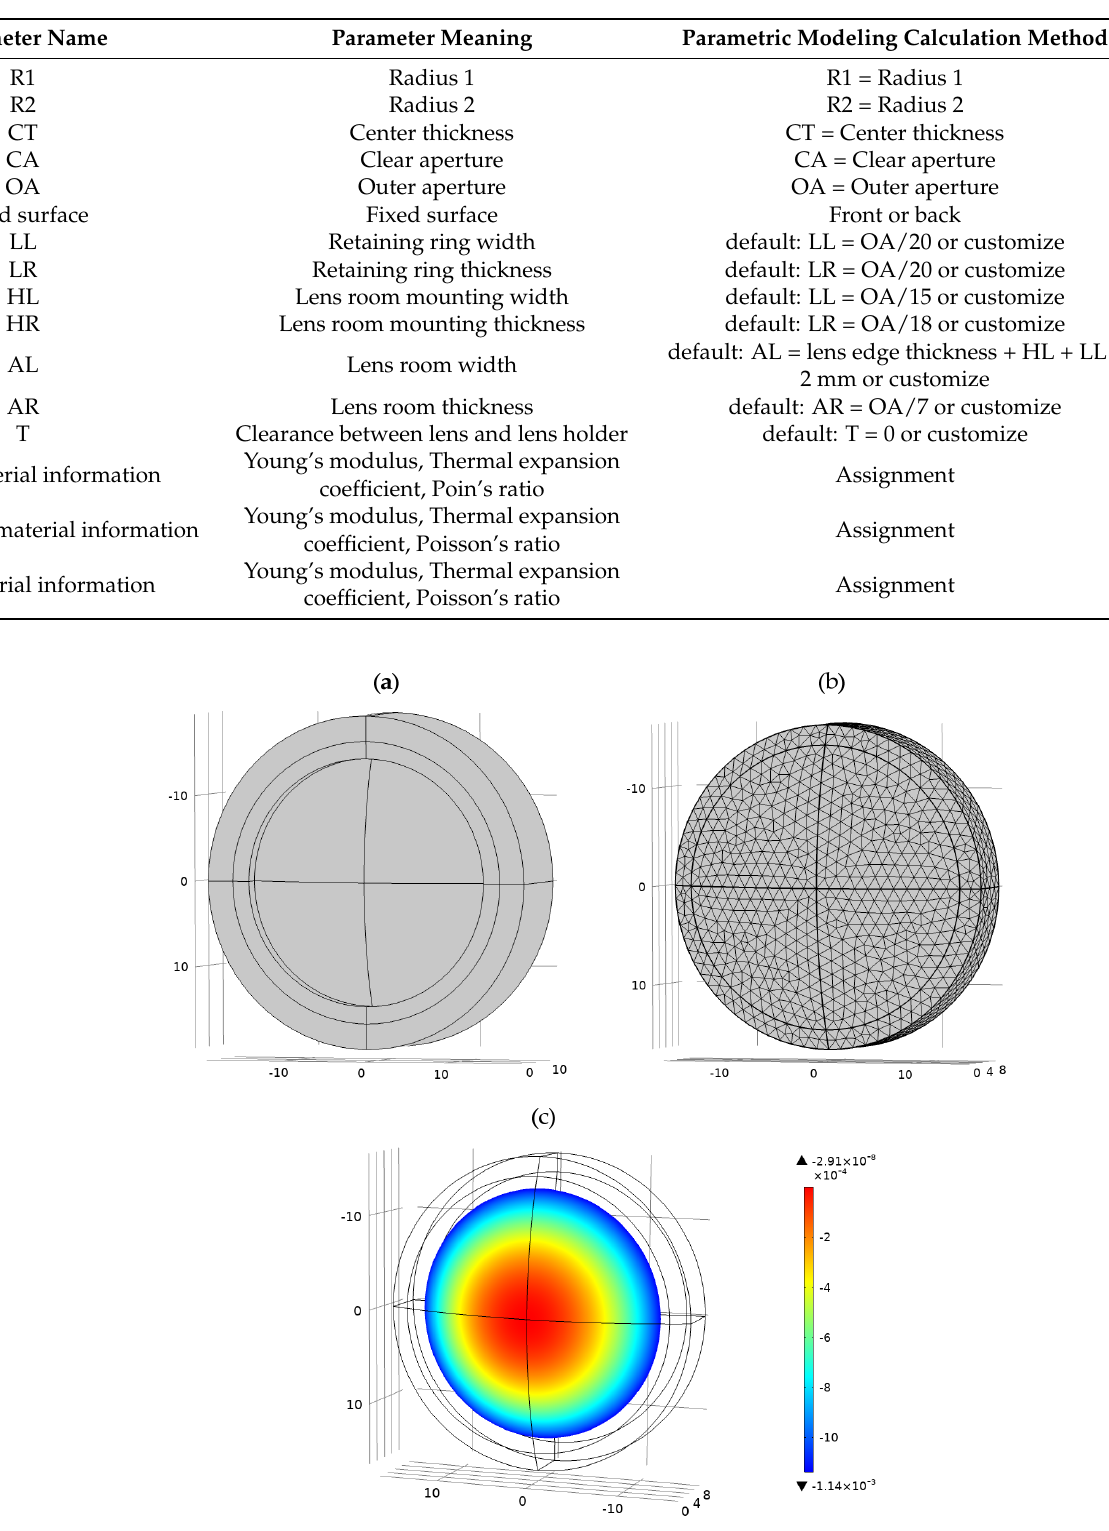
Table 5. Parametric data.